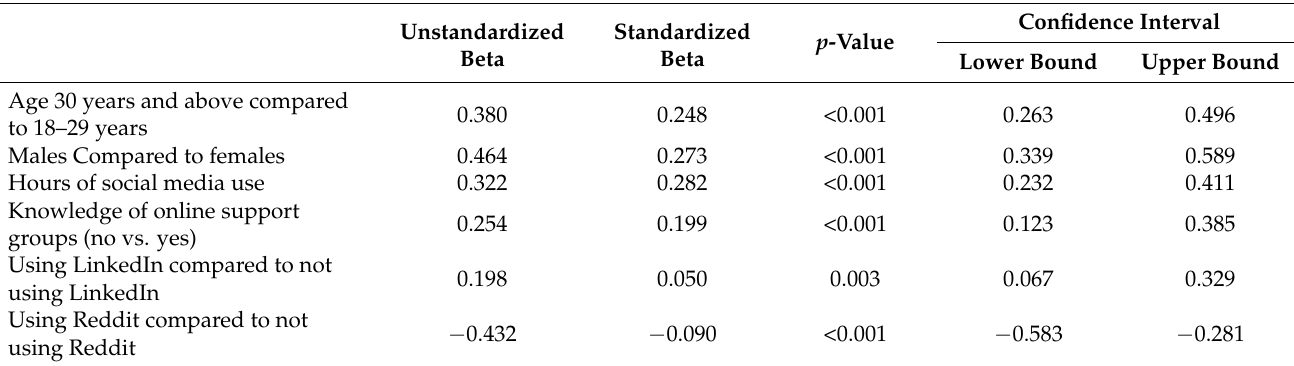
Table 8. Multivariable analysis of the Westerner